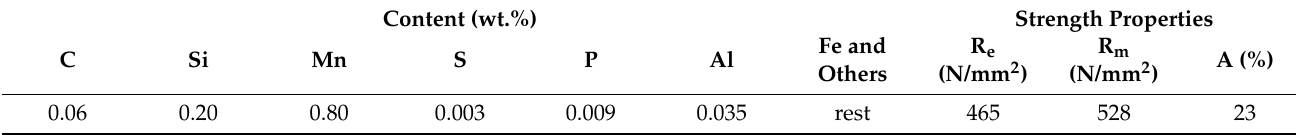
Table 1. Chemical composition and strength properties of HSLA